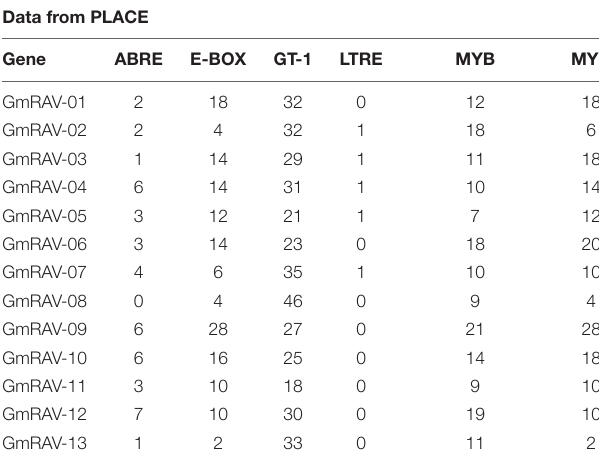
TABLE 2 | Distribution of abiotic stress-related cis -acting elements in soybean RAV gene promoters. Data from PLACE